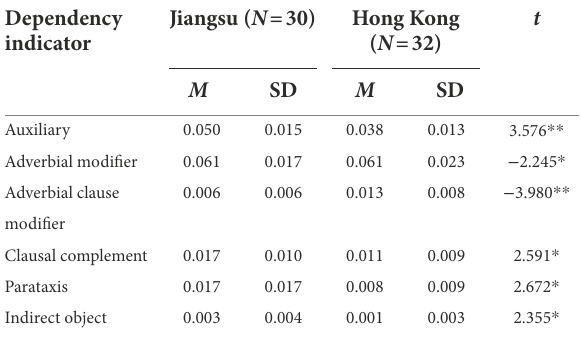
TABLE 2 Syntactic differences in written English between learners from the two